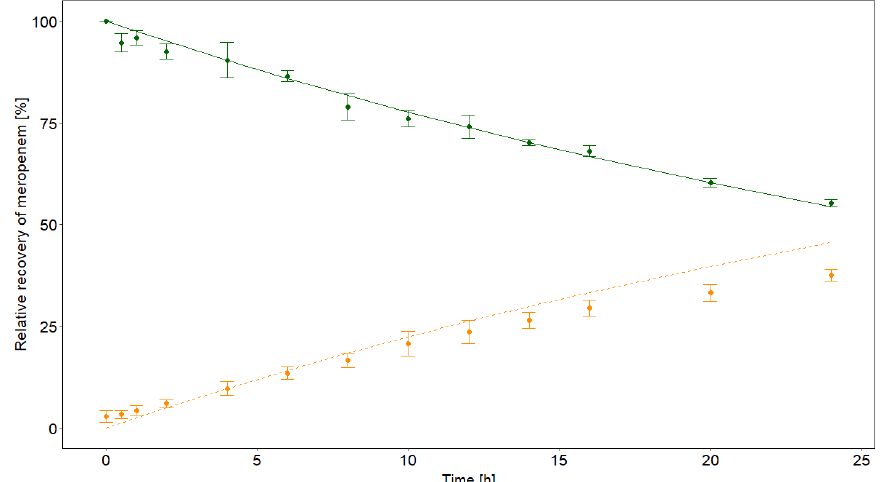
Figure 2. Combined degradation profiles of 2, 10, and 50 mg/L meropenem in vitro in buffered serum at 37 °C. Green dots: mean measured concentrations of meropenem. Orange dots: mean measured concentrations of the open-ring metabolite (ORM). Standard deviations are depicted with error bars. The non-linear degradation is shown by the green line, while the orange dotted line indicates the theoretical increase in ORM.